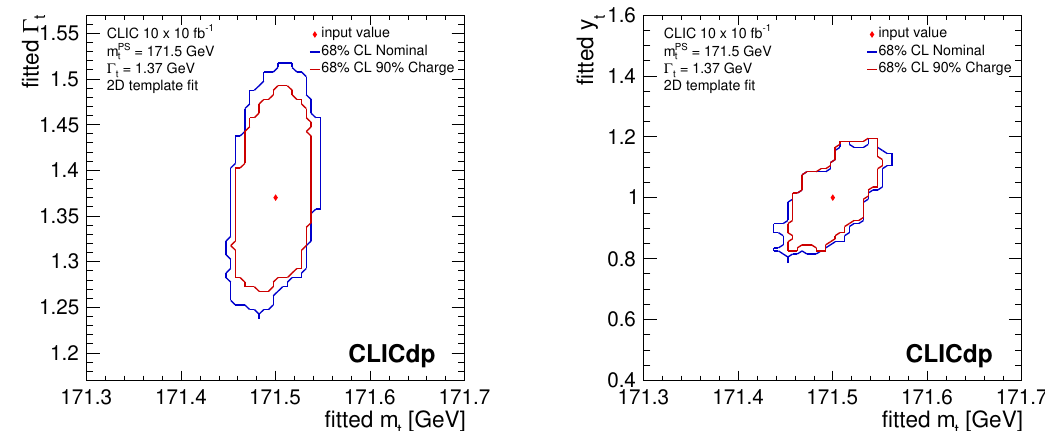
Figure 12. 68% CL statistical uncertainty contours of two-parameter (cid:12)ts to the top threshold region, combining the top-quark mass and width (left) and the top-quark mass and the top Yukawa coupling (right). The contours are shown for both the nominal luminosity spectrum and the ‘reduced charge’ option, in both cases assuming an integrated luminosity of 100 fb (cid:0) 1